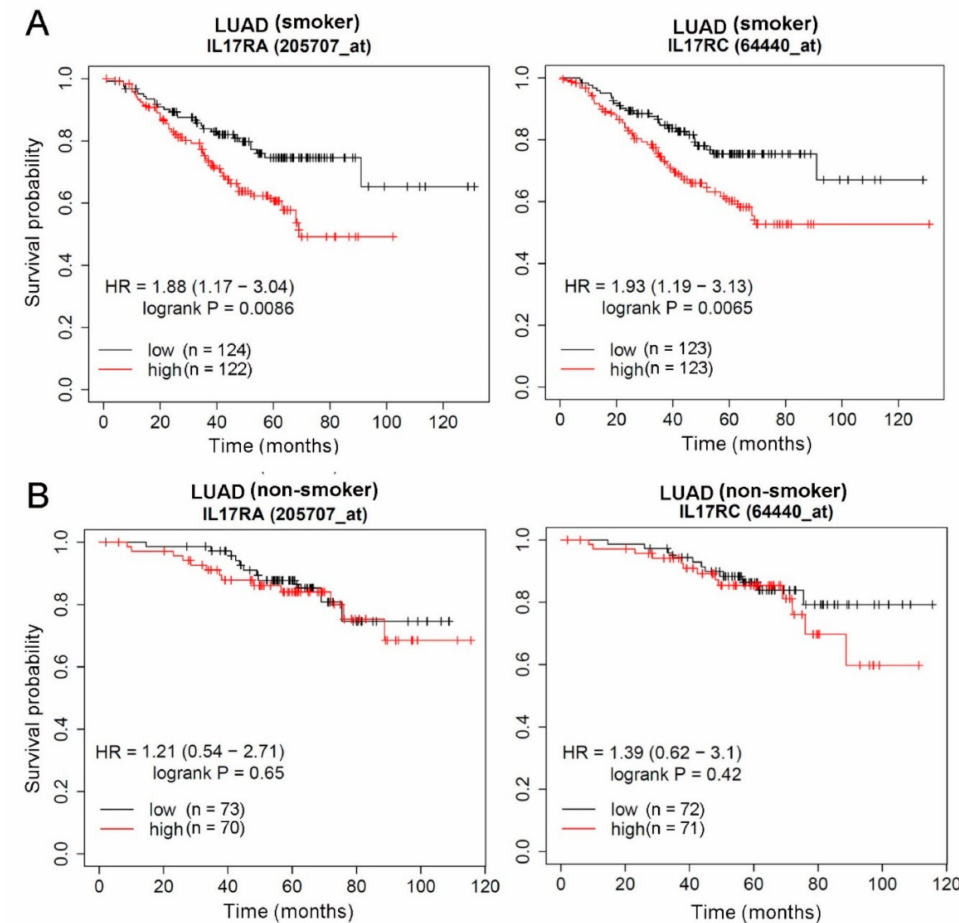
Figure 2. Prognosis of interleukin-17 receptor A (IL-17RA) and IL-17RC in lung adenocarcinoma (LUAD) patients with different smoking statuses. ( A ) Correlations of IL-17RA and IL-17RC expression levels with the overall survival (OS) rate in LUAD patients with a smoking history. ( B ) Correlations of IL-17RA and IL-17RC expression levels with the OS rate in LUAD patients without a smoking history. The Affymetrix ID is valid: 205707_at (IL-17RA) or 64440_at (IL-17RC). Gene expressions were dichotomized into high and low values using the median as a cutoff. HR, hazard